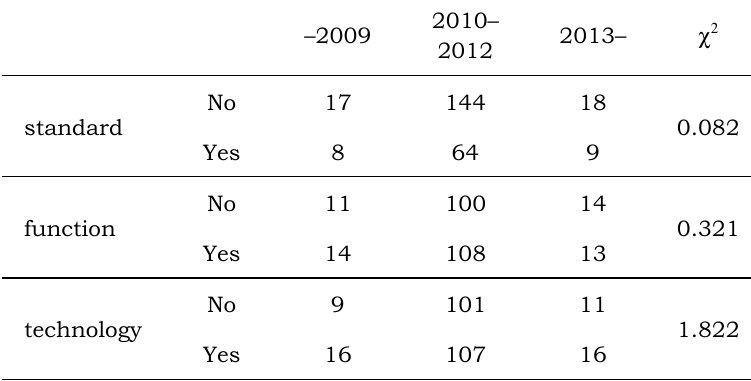
2010– 2013– χ –2009 2012